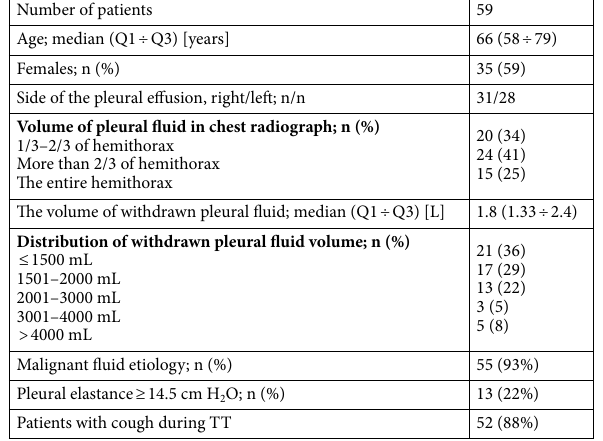
Table 1. Characteristics of the study